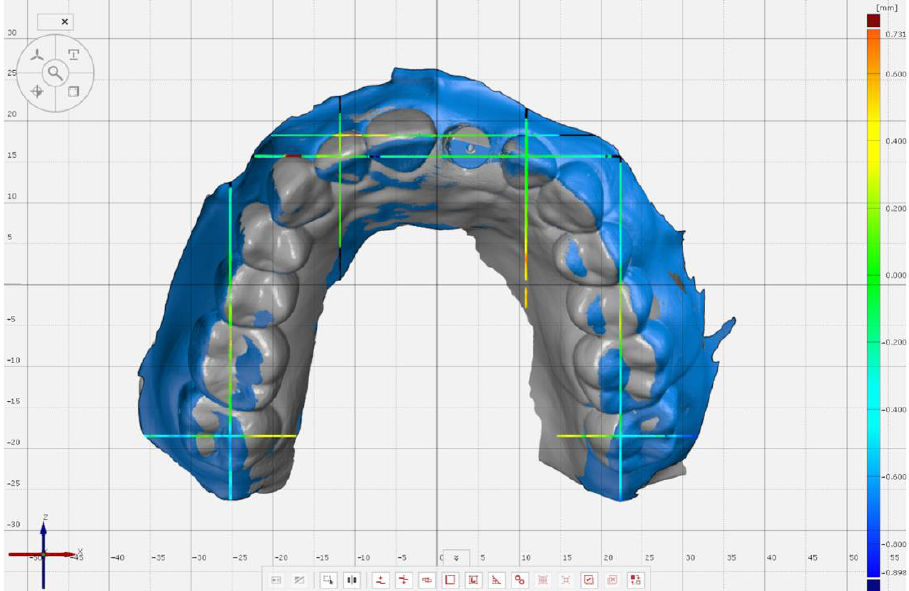
Figure 3. Measurement points (Left 2nd molar: Buccal, palatal, and distal gingival margins, mesio- palatal and distopalatal cusp tips, and most buccal point of the tooth. Left lateral incisor: Buccal, palatal, and mesial gingival margins, most mesial and incisal point of the tooth. Right central incisor: Mesial gingival margin and most mesial point of the tooth. Right lateral incisor: Buccal and gingival margins and most incisal point of the tooth. Right 2nd molar: Buccal, palatal, and distal gingival margins, mesiopalatal and distopalatal cusp tips, and most buccal point of the tooth) on complete- arch scan at selected planes when superimposed to the reference scan.